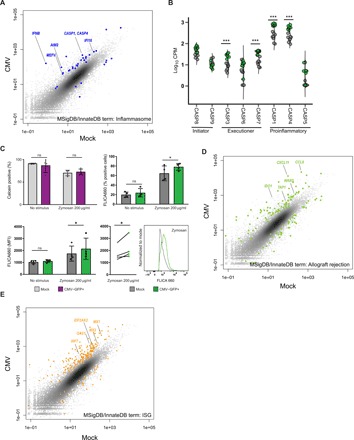
CMV infection of monocytes induces the expression of the AIM2 and IFI16 inflammasome and a diverse array of pro-inflammatory mediators associated with allograft rejection.Scatter plot showing all transcripts detected by RNA-Seq in mock- and CMV-infected CD14+/16− monocytes. (A) Differentially expressed genes within curated lists related to inflammasome activation (blue) are highlighted. (B) Binary violin plots of mRNA expression of all caspases in mock- and CMV-infected monocytes. (C) Percentage of calcein-positive mock- and CMV-infected cells (top left) and caspase protein expression in mock- and CMV-infected monocytes 24 hours after infection with additional challenge with zymosan (n = 4; P = 0.03 and 0.02, respectively, two-way ANOVA with Bonferroni post-test), as measured by percentage of cells positive for FLICA (top right) and MFI of FLICA (bottom) with representative histogram (far right). (D) Differentially expressed genes within curated lists related to allograft rejection (green) and (E) ISGs (brown) are highlighted. P values (C) and adjusted FDR P values (B) are denoted as *P < 0.05, **P < 0.01, ***P < 0.001, and ****P < 0.0001. FLICA, fluorochrome inhibitor of caspase activity; ISG, interferon-stimulated genes.